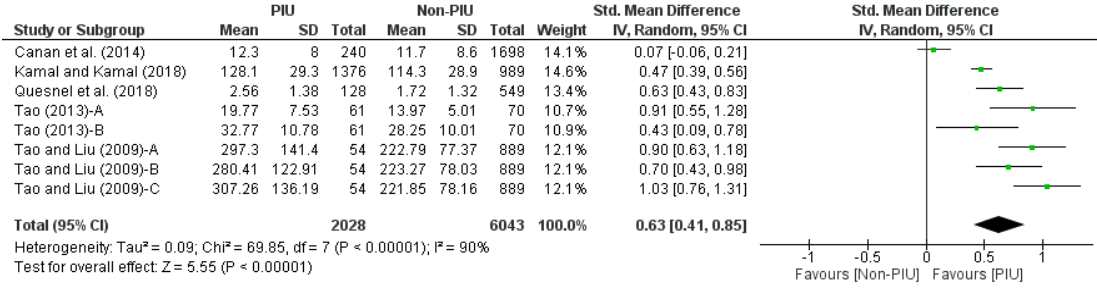
Figure 3. Forest plot of meta-analysis with continuous data.